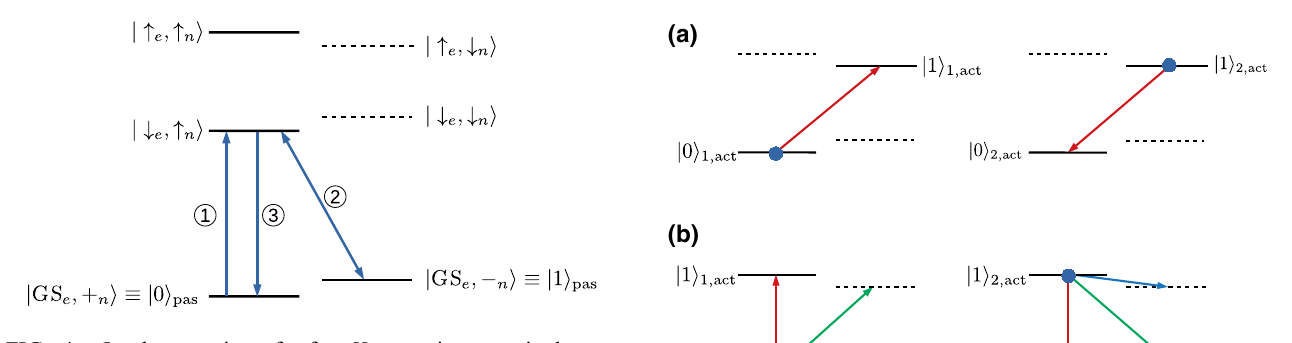
FIG. 4. Implementation of a fast X gate via an excited state. The blue arrows denote π pulses that switch the population of the states they connect. The pulses are applied in the order of the indicated numbers. The differing g -factor anisotropies in the ground and excited doublets ensure sizable matrix elements for all three transitions.